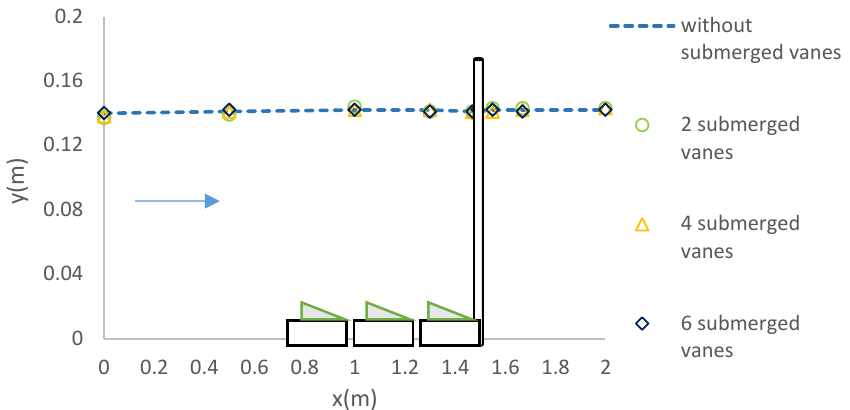
Fig.10. comparison of the water surface profile at 𝑍 = +𝐷 , 𝑉/𝑉𝑐 = 0.95 , 𝛼 =